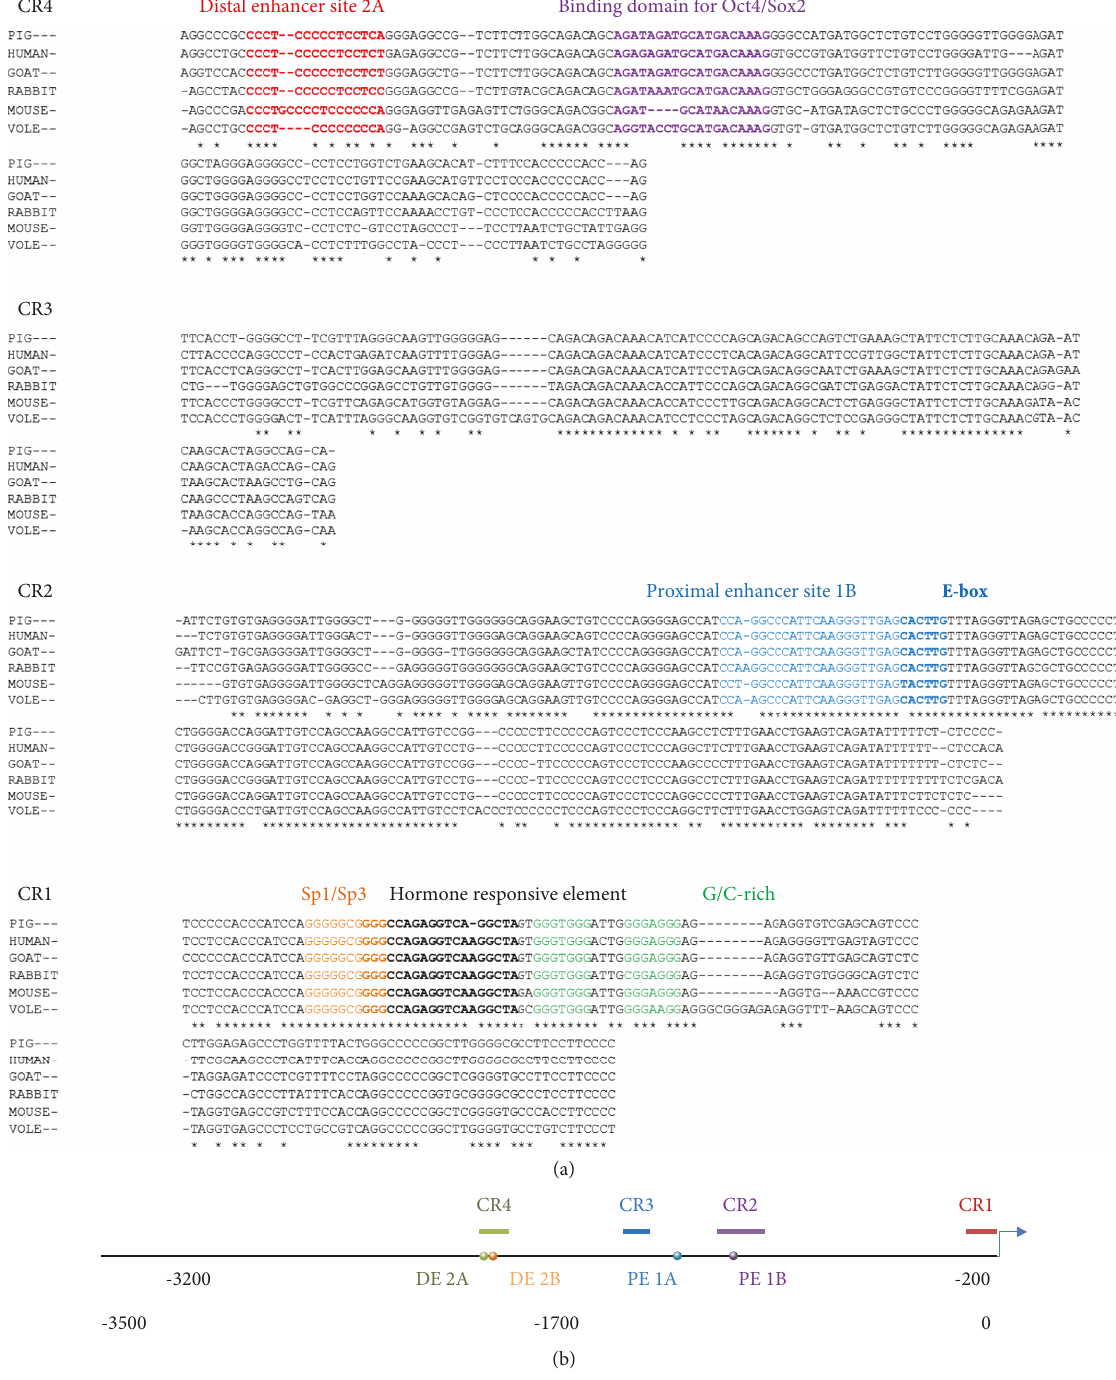
Figure 3: Alignment of porcine OCT4 transcriptional regulatory regions with those of fi ve other mammalian orthologs and schematic representation of the porcine OCT4 transcriptional regulatory region. (a) Conserved region 4 (CR4) contains distal enhancer site 2A (DE2A) and the binding domain for Oct4 and Sox2 ( Oct4 / Sox2 ). Conserved region 3 (CR3). Conserved region 2 (CR2) contains proximal enhancer site 1B (PE1B). Conserved region 1 (CR1) contains the Sp1/Sp3 site, hormone responsive element (HRE), and three G/C-rich sites. The asterisks show the nucleotides that are identical among the six species. (b) The black line represents the 3.5kb upstream region (located at positions -3500/-1) of OCT4 in pig. The four upper lines of CR1, CR2, CR3, and CR4 represent the four conserved regions, respectively. The circles show the locations of distal enhancer site elements 2A (DE2A) and 2B (DE2B) and the proximal enhancer site elements 1A (PE1A) and 1B (PE1B). The arrow indicates the translational initiation site of the OCT4